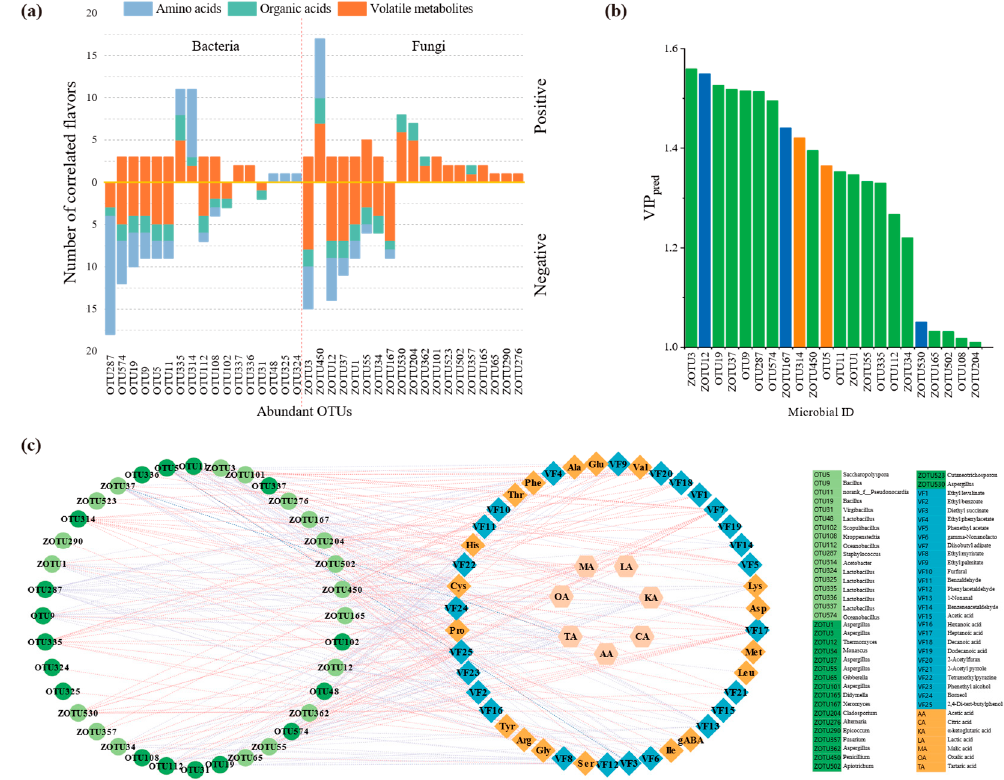
Figure 5. Correlation analysis between microbiota and flavor during fermentation. ( a ) Summary of significantly related flavors. ( b ) OTUs with VIP (pred) > 1 by O2PLS analysis. Blue and orange refer to fungal and bacterial OTUs with average relative abundance > 10% in at least one stage, respectively. ( c ) Correlation networks between microbiota and flavor during fermentation. Red and blue lines represent positive and negative correlations, respectively.